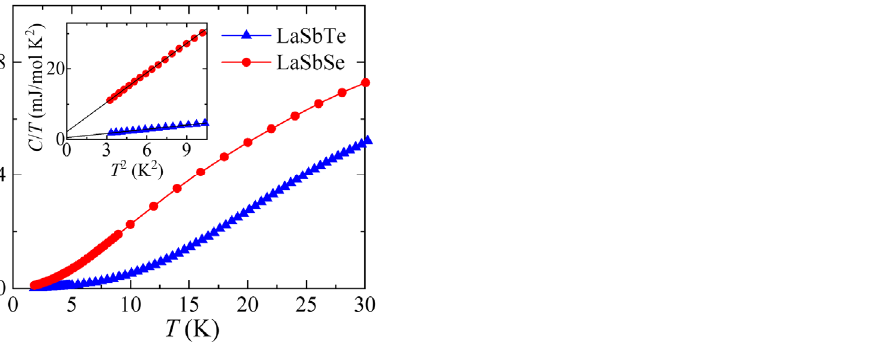
Figure 4. Temperature dependent specific heat divided by temperature C / T for LaSbSe and LaSbTe. Inset: linear fit for C / T vs. T 2 at low temperatures for LaSbSe and LaSbTe.